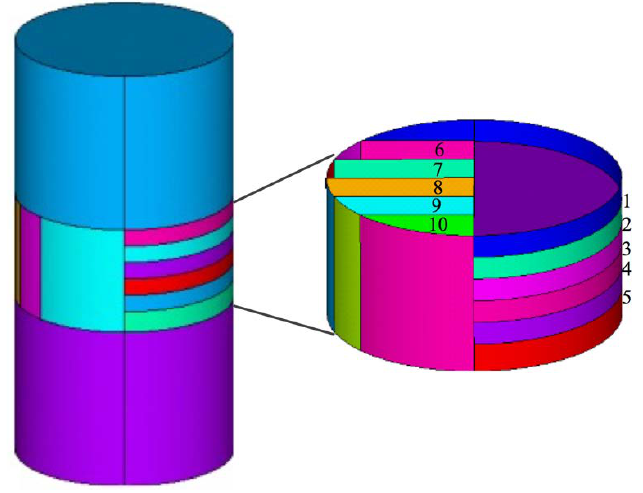
Figure 8. Location of thin sections obtained from the different loading directions of the specimen.